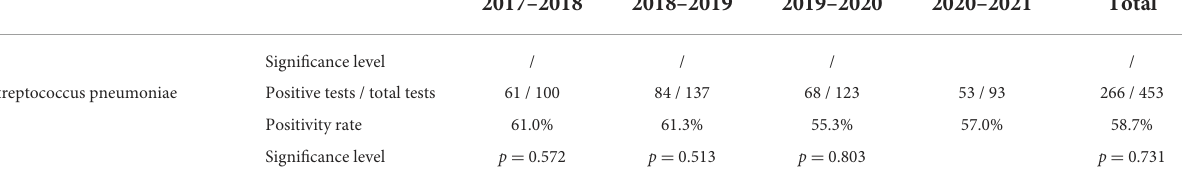
absent from April 2020 until January 2021, whereas no clear seasonal pattern could be distinguished during other years.